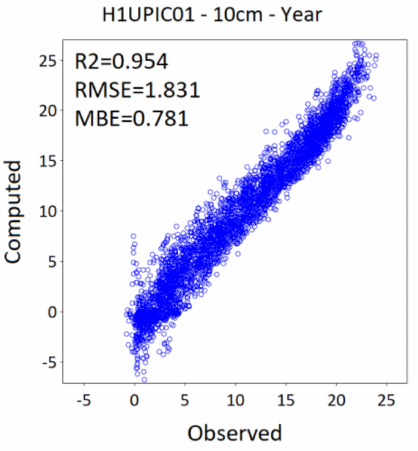
Figure A7. Validation at site H1UPIC01 for 10 cm soil depth.